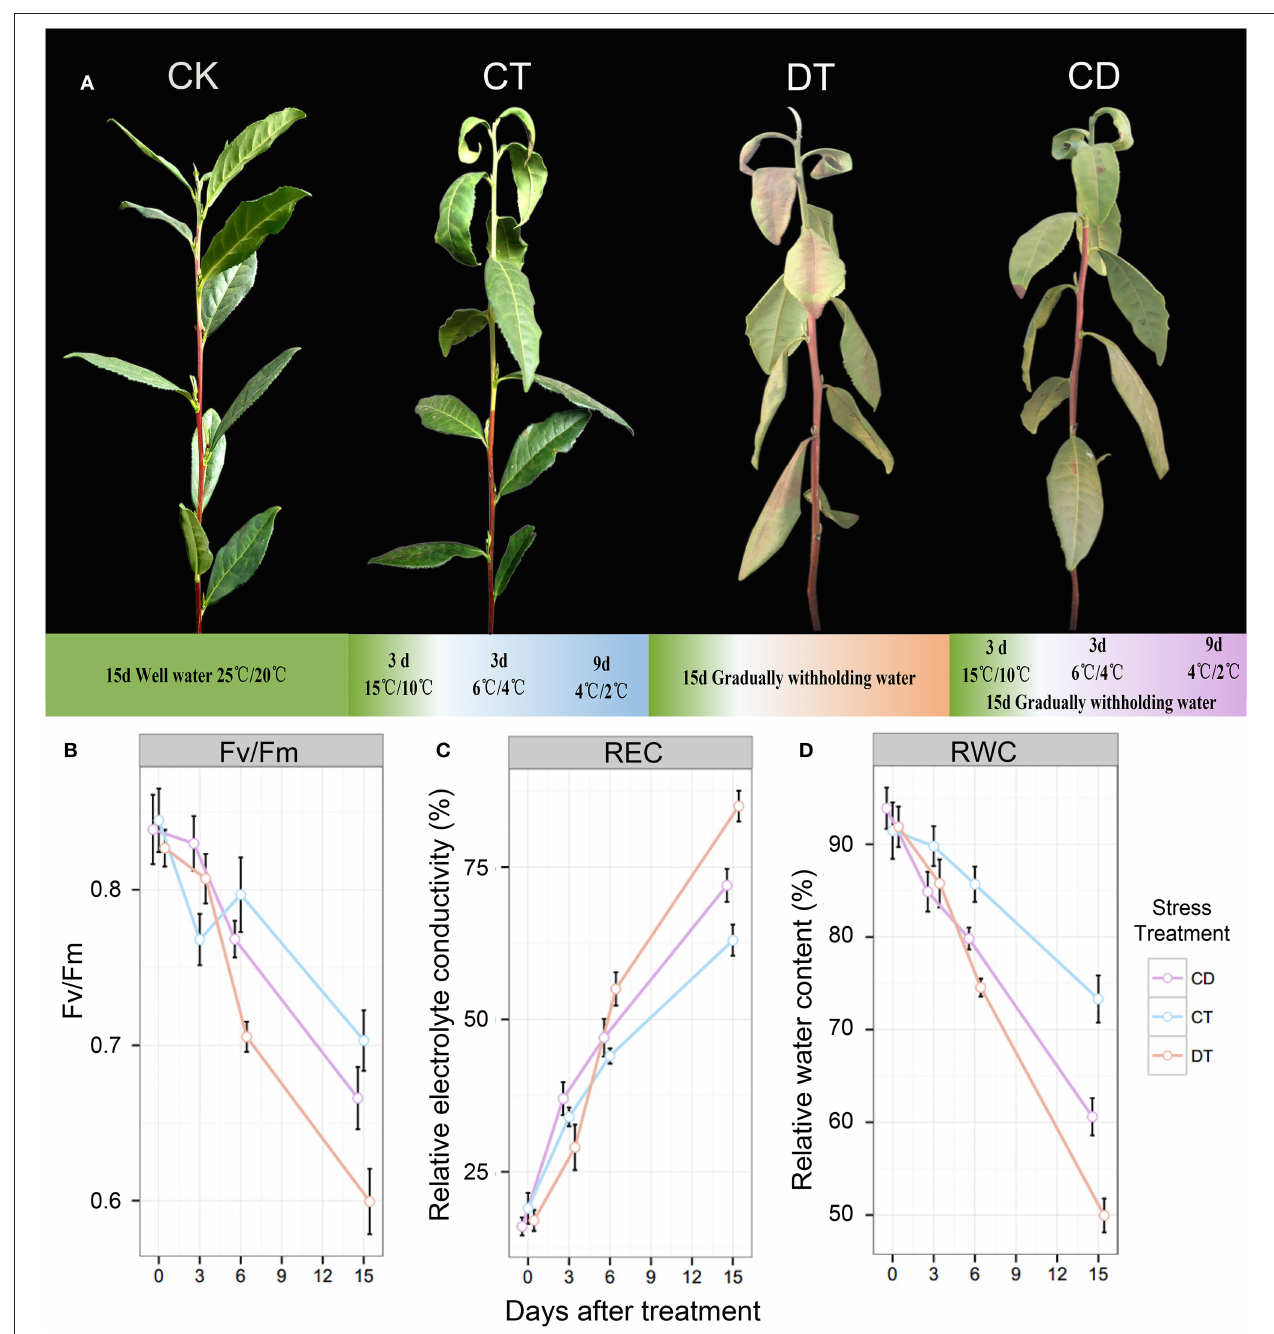
FIGURE 1 | The phenotypes and physiological analyses of tea plants under CT, DT and CD. (A) The phenotypes of control (CK) and plants treated with gradually cold (CT) and drought (DT) stress individually or together (CD) after 15 days. (B) Leaf maximum photochemical quantum yield of PS II ( Fv/Fm ), (C) leaf relative electrolyte conductivity (REC), and (D) relative water content (RWC) were determined at six time-points (0, 3, 6, 9, 12 and 15 days) during CT, DT, and CD.